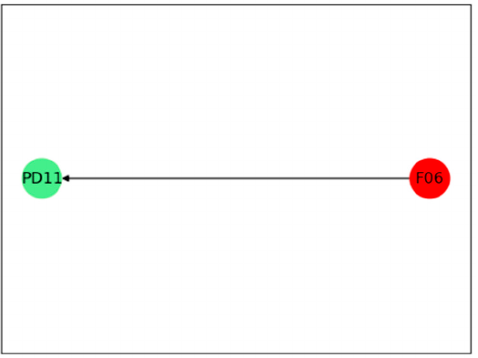
Figure 16. Fault propagation digraph in case one.